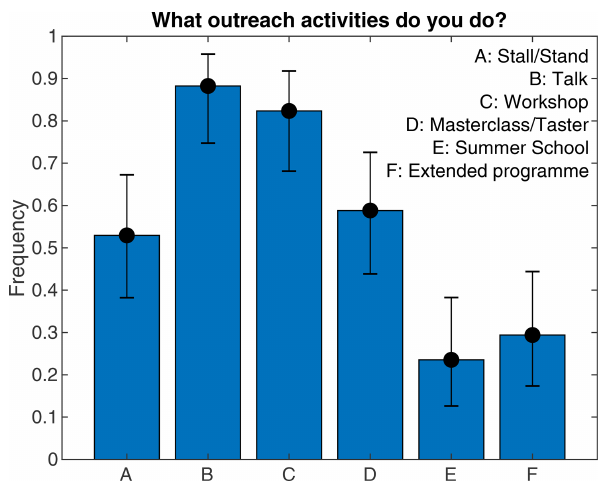
Figure C1. Bar chart of types of school outreach activities un- dertaken by university researchers and engagement professionals ( n = 17). Error bars denote the standard (1 σ ) Clopper and Pearson (1934)